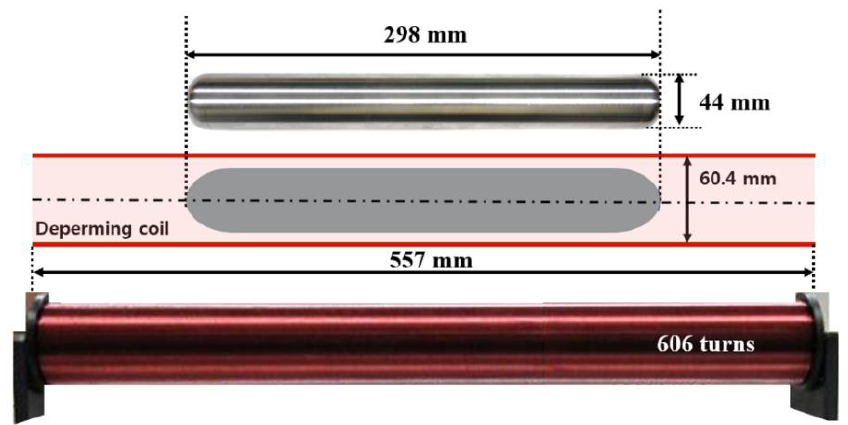
Figure 13. Specimen and solenoid coil for experiment and simulation of demagnetization.